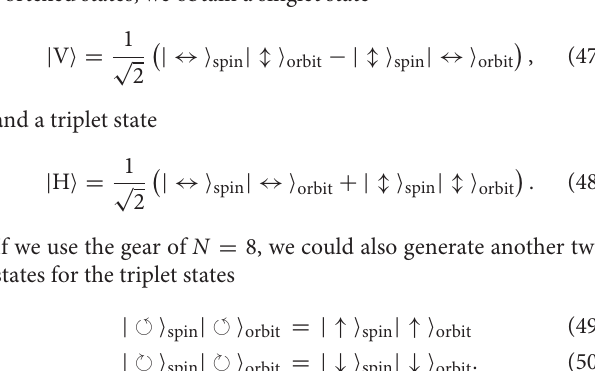
FIGURE 13 | Diagonal vortex generated from the gear of N π/ 2 ahead of the phase of the input 1. The mode profile of a vortex is obtained at z horizontal electric field E x . (C) The amplitude ( dipole is recognized for E x with a node at the center. (E–H) The local spin components (s 0 , s 1 ,s 2 ,s 3 ), and (I–L) normalised Stokes parameters (S 0 , S 1 ,S 2 ,S 3 ) are also